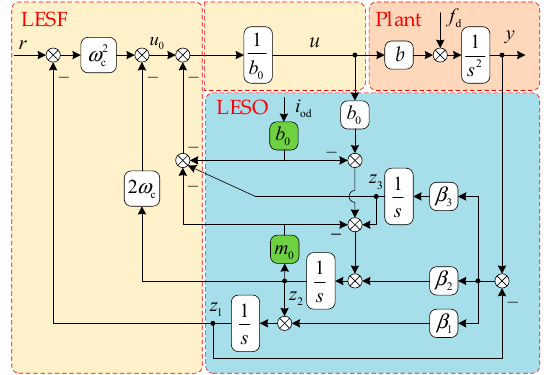
Figure 7. Proposed LADRC scheme based on known disturbance